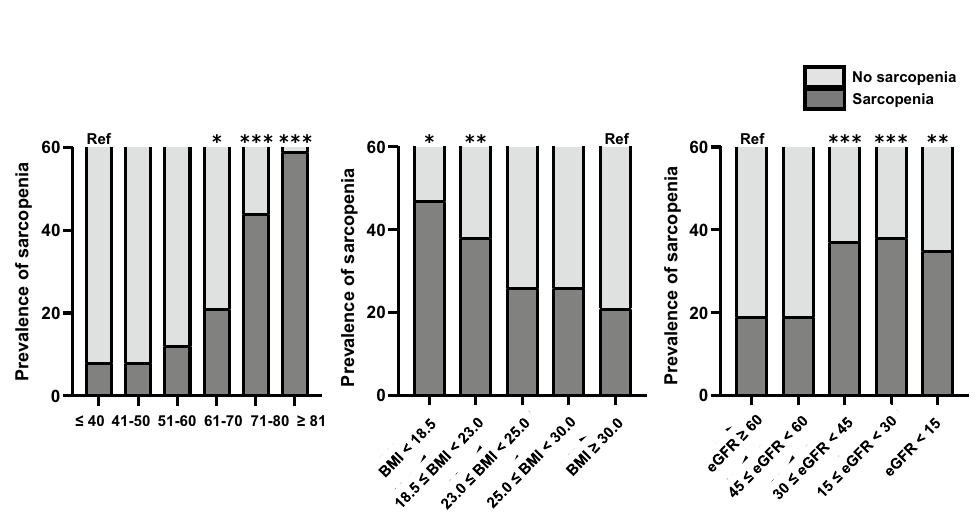
Figure 3. Prevalence of sarcopenia. Sarcopenia increases rapidly with age, especially in elderly patients aged > 71 years. The prevalence of sarcopenia decreased rapidly as body mass index (BMI) categories progressed; but in patients with BMI ≥ 23 kg/m 2 , BMI did not affect the prevalence of sarcopenia. Sarcopenia significantly associated with the estimated glomerular filtration rate (eGFR) and chronic kidney disease (CKD) stages; the prevalence of sarcopenia in patients with eGFR < 45 mL/min/1.73 m 2 increased rapidly. *** P < 0.001; ** P < 0.01; * P < 0.05; ref,